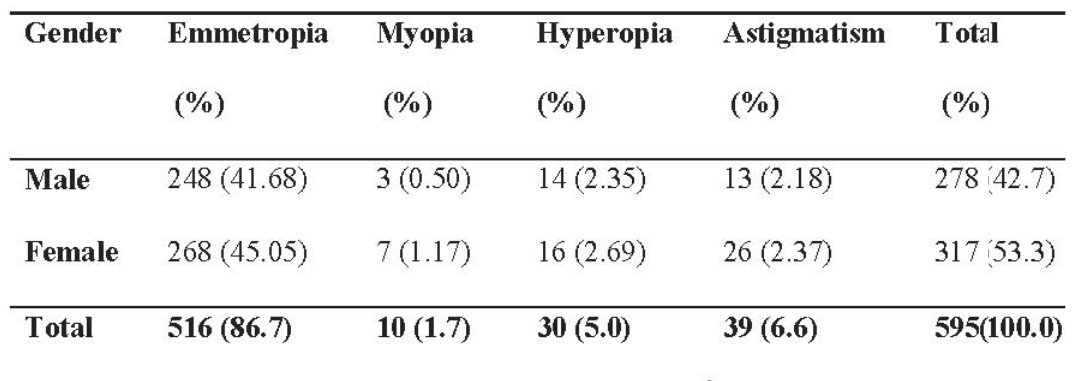
Table 2: Distribution of Refractive Errors by Gender showing the Prevalence of Myopia, Hyperopia and Astigmatism